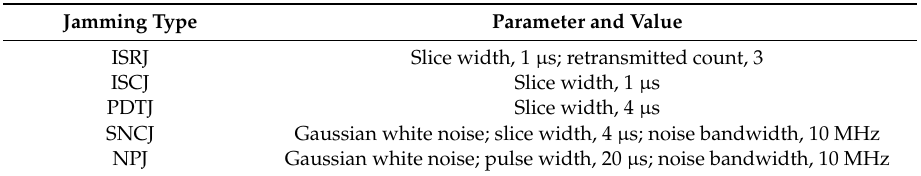
Table 2. Simulation parameters for the jamming signal. Note: ISCJ, interrupted-sampling